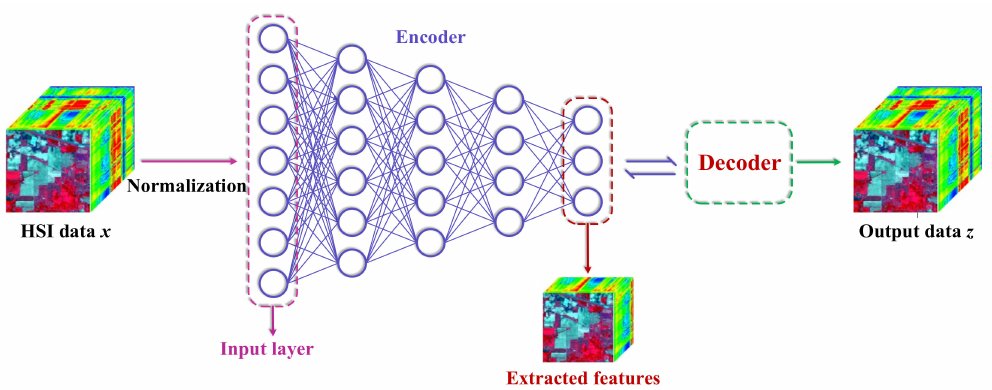
Figure 4. Network structure of the proposed stacked autoencoder